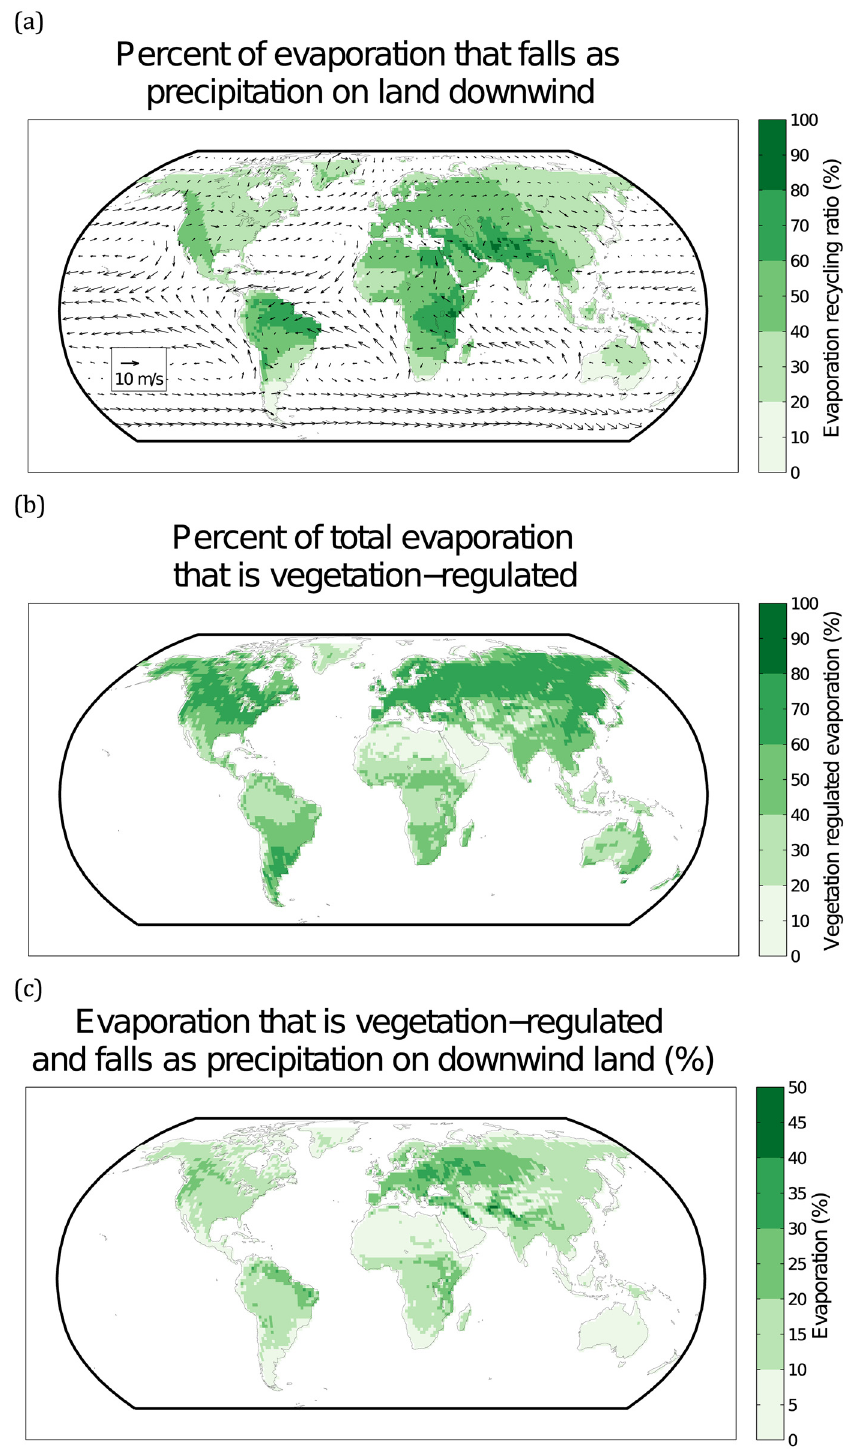
Fig 1. Global Sources of Vegetation-regulated Moisture Recycling, showing the amount of evaporation from land that falls as precipitation on land (as opposed to oceans) downwind (a); the percent of total evaporation that is vegetation-regulated, relative to barren land (b); and the amount of vegetation-regulated evaporation that falls as precipitation on land downwind (c). The arrows in panel (a) depict annual average wind directions in the lower level of the atmosphere. Note that the maximum of (c) is